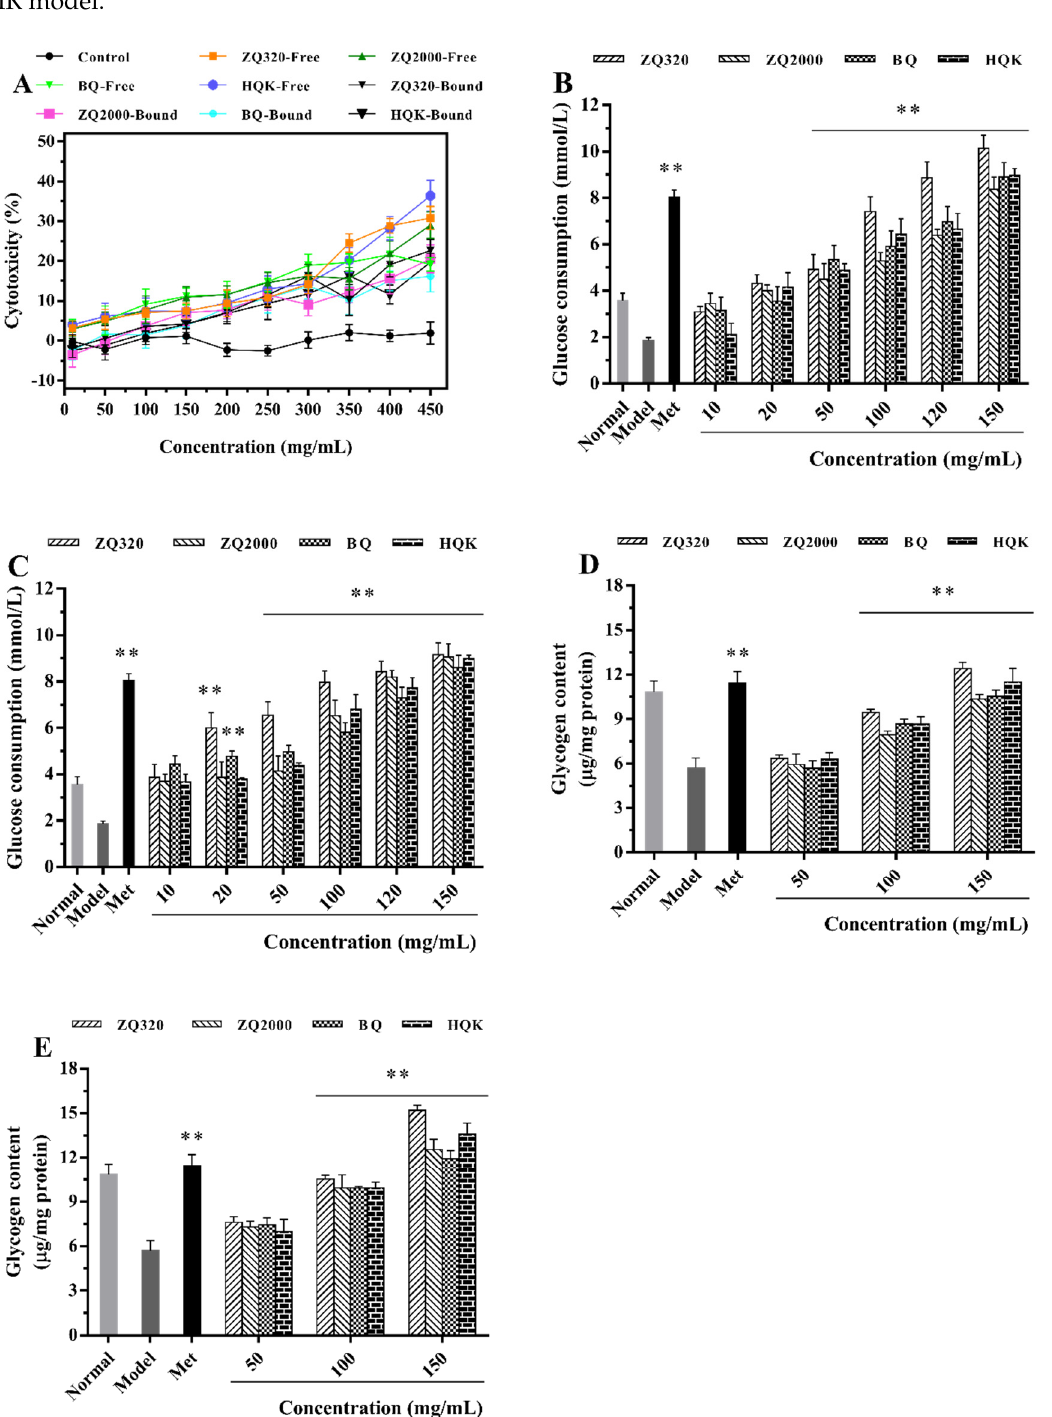
Figure 3. Cytotoxicity ( A ), glucose consumption of HepG2 cells in free ( B ) and bound ( C ) fractions, and glycogen accumulation of HepG2 cells in free ( D ) and bound ( E ) fractions of four highland barley varieties (mean ± SD, n = 3). ** Correlation is significant at the 0.01 level (2-tailed).